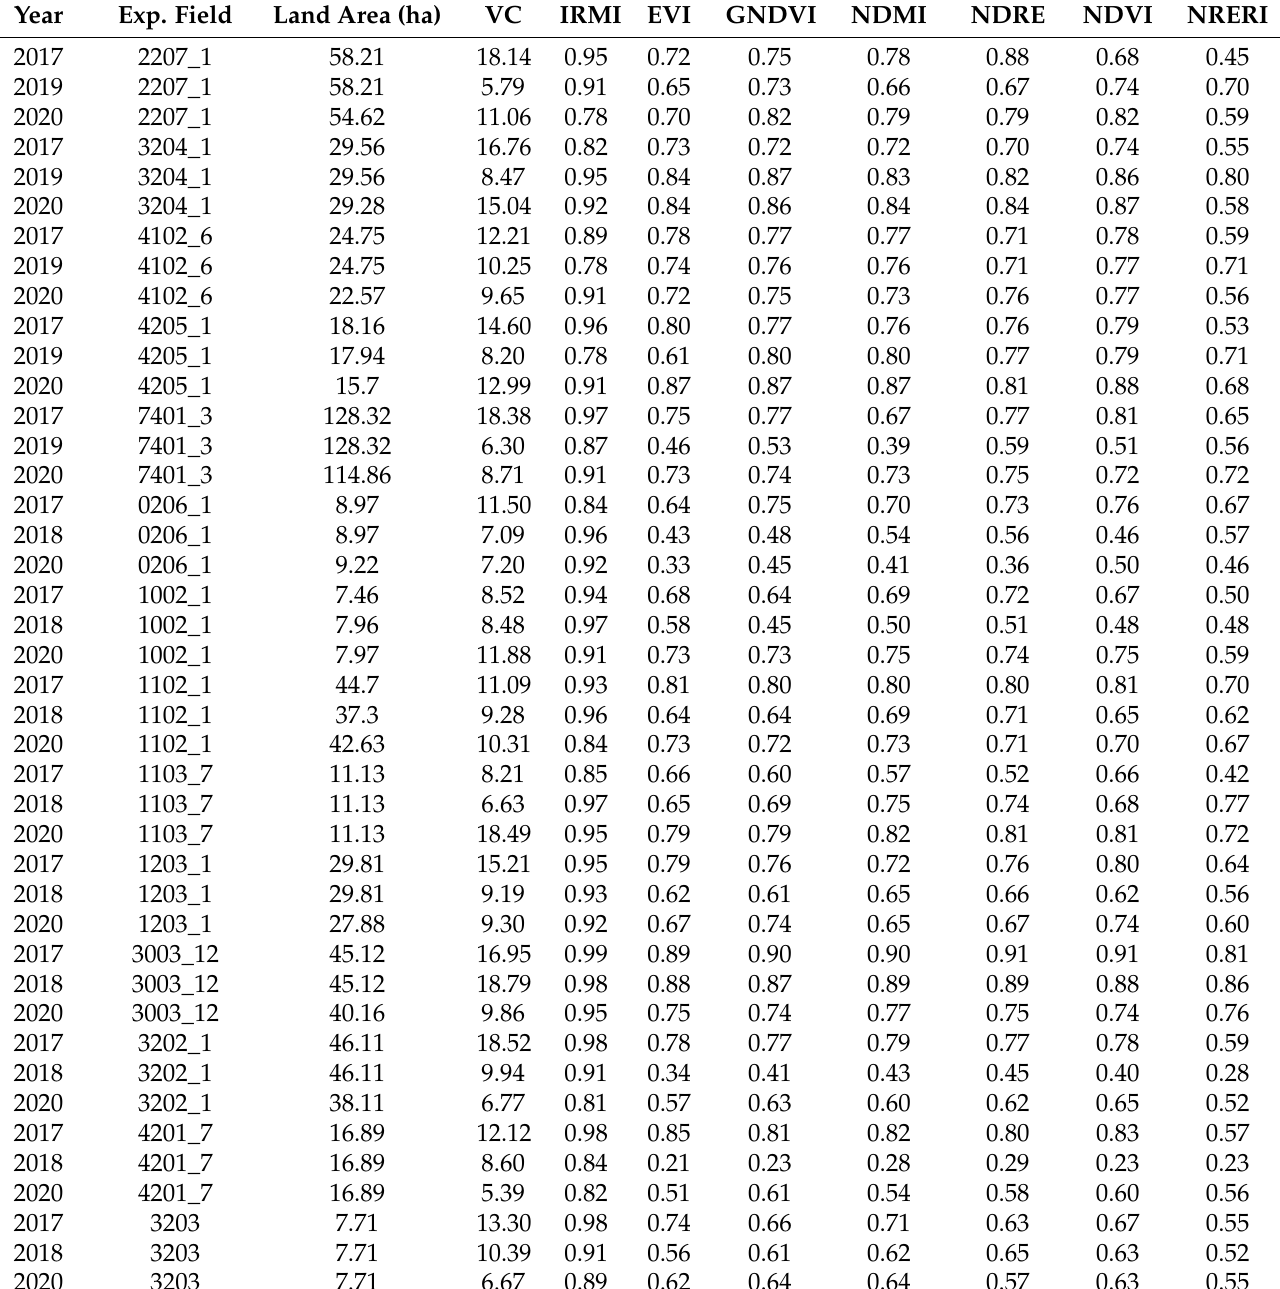
Legend: VC = variance coefficient. Significant values are indicated by red